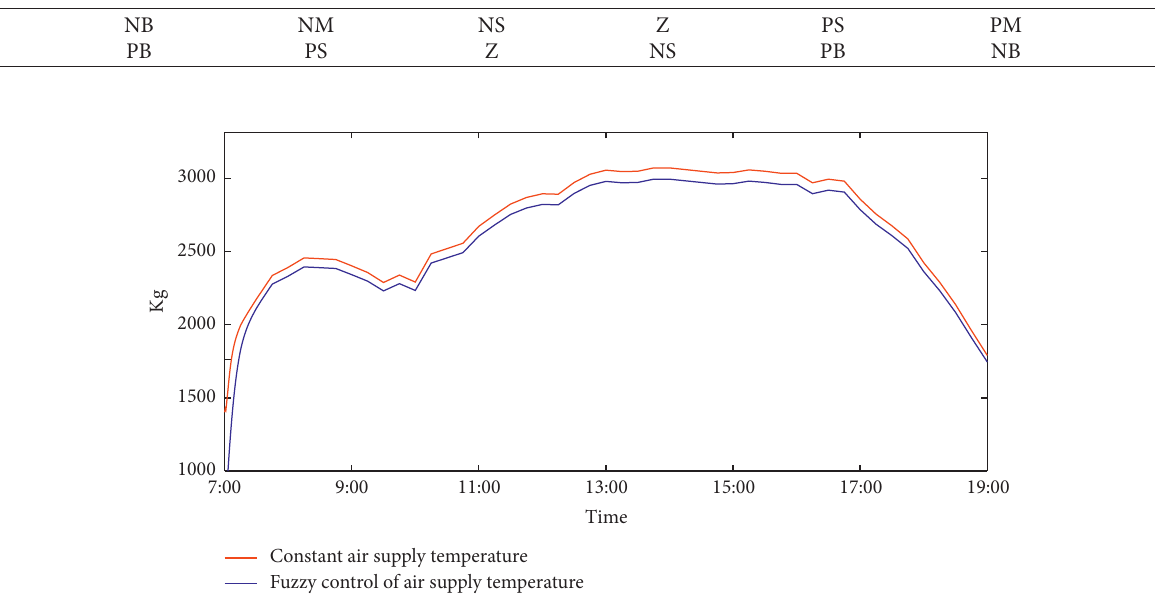
Figure 15: Comparison of air supply volume of the system.